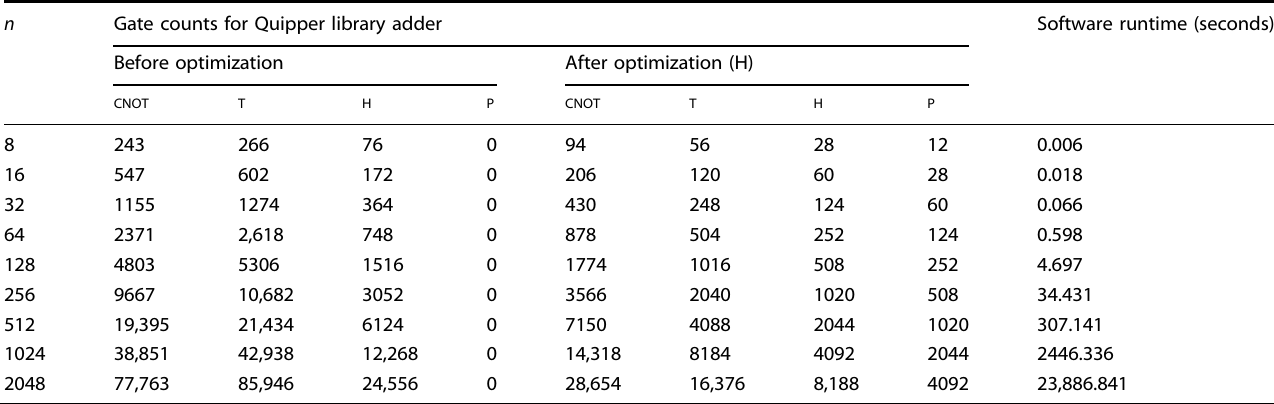
Table 2. Heavy optimization of Quipper library